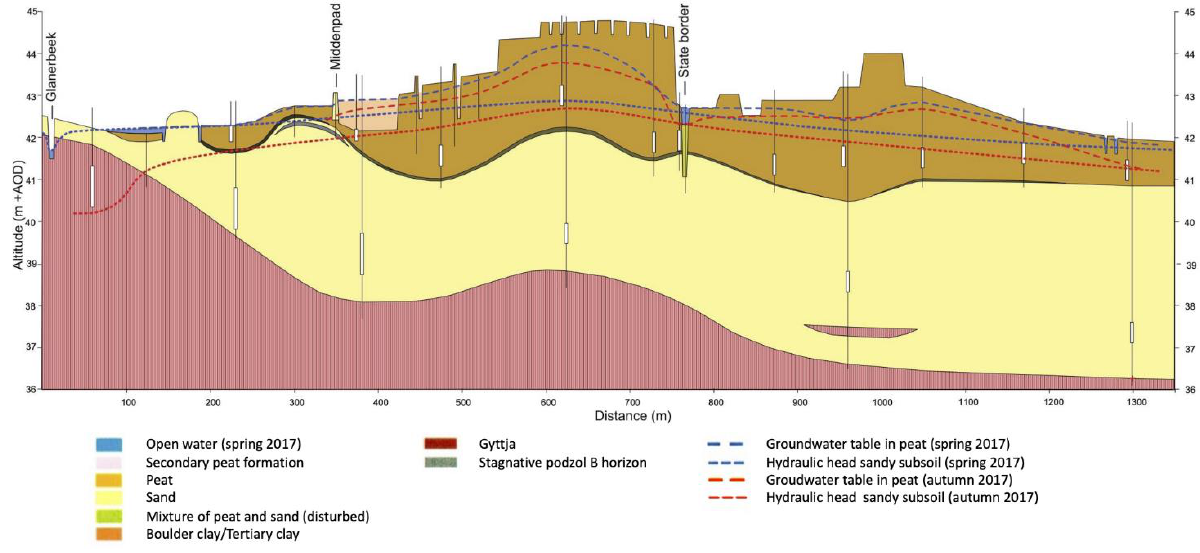
Figure 2. Geohydrological cross section of Transect 3 (after Bell et al . 2018). Locations and depths of groundwater piezometers are indicated by